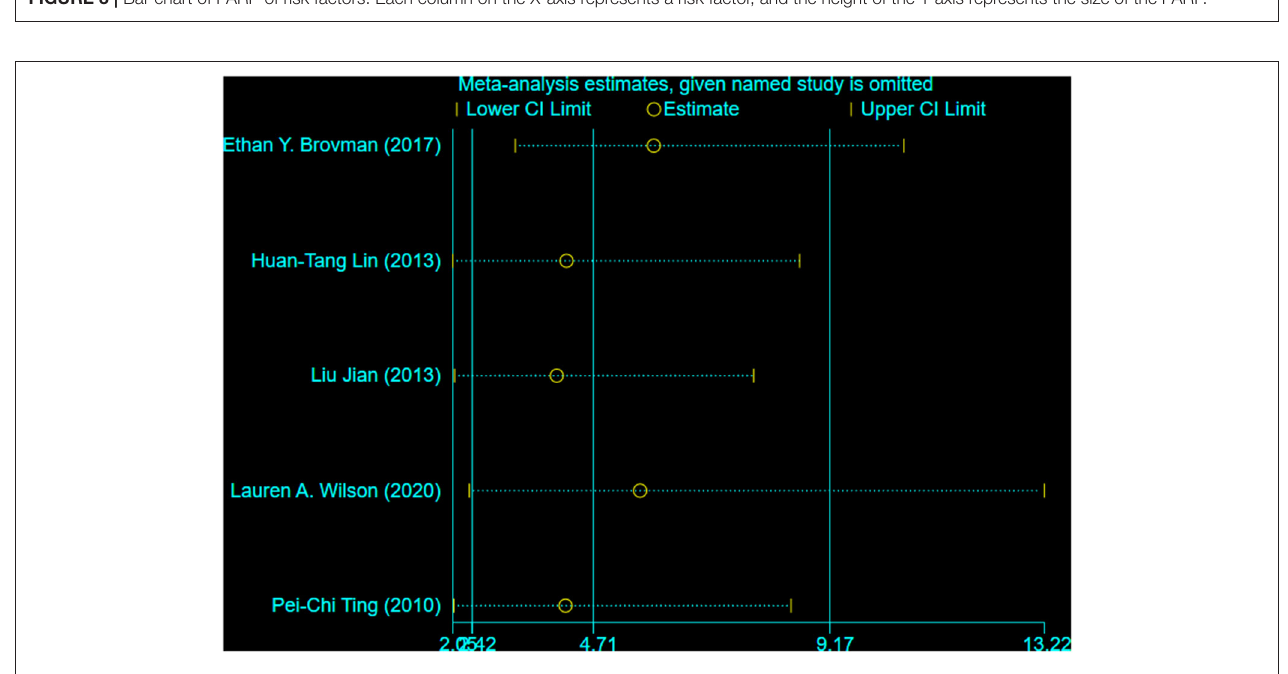
FIGURE 4 | Sensitivity analysis diagram of